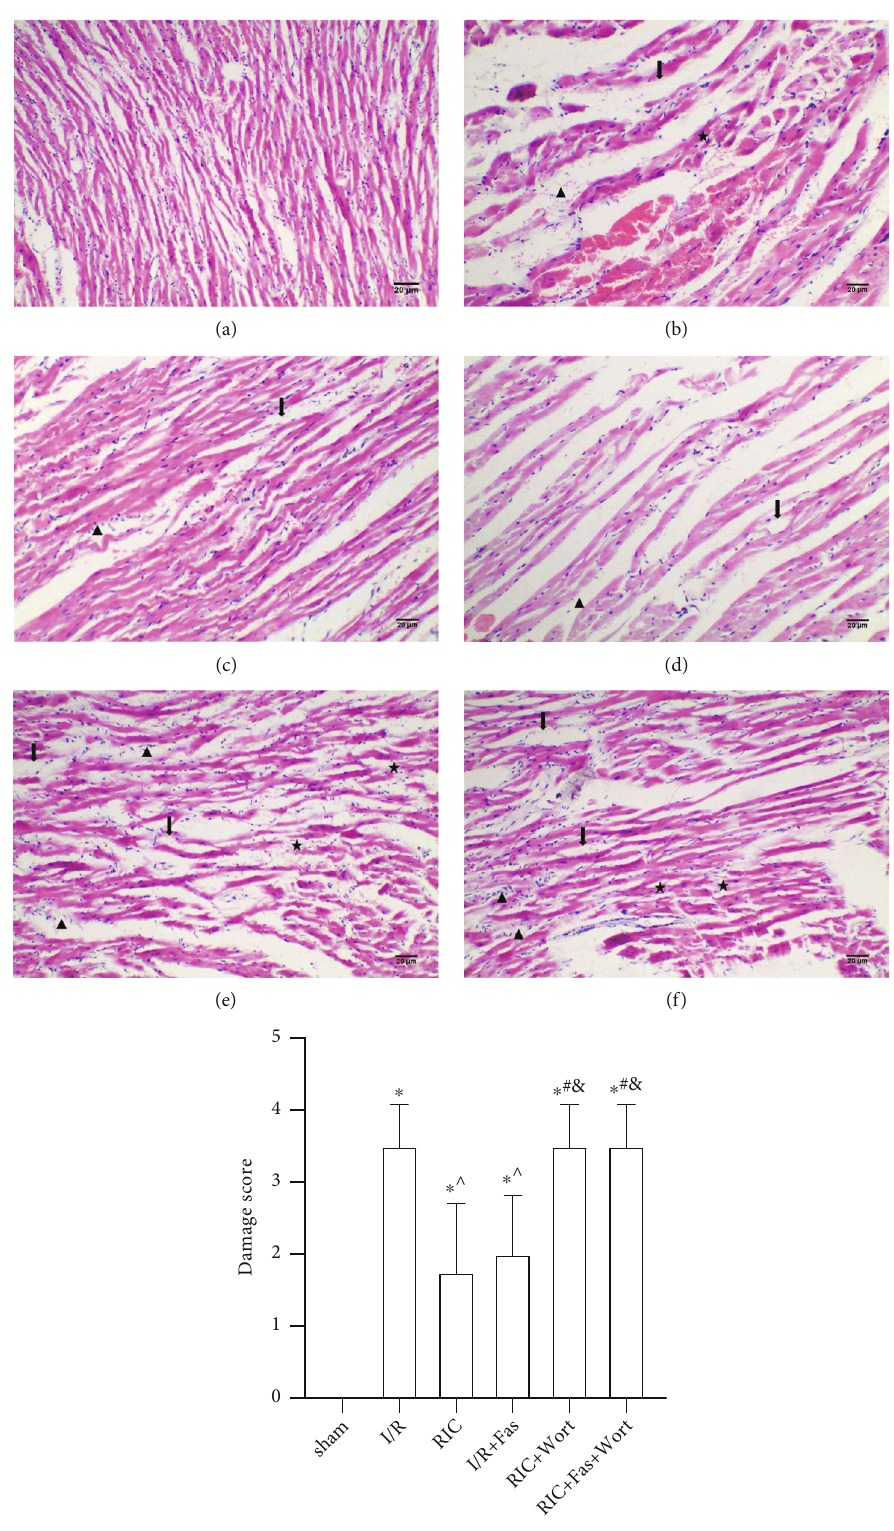
Figure 4: The histological changes in the myocardial tissue in the di ff erent groups ( × 100). Scale bar, 20 μ m. ( ★ ) myocardial fi ber disorganization; ( ↓ ) hemorrhage, stromal edema; ( ▲ ) in fl ammatory cell in fi ltration. (a) Sham group; (b) I/R group; (c) RIC group; (d) I/ R+Fas group; (e) RIC+Wort group; (f) RIC+Fas+Wort group; (g) damage score in di ff erent groups ( n = 4 ). ∗ P < 0 : 05 vs. sham group; ^ P < 0 : 05 vs. I/R group; # P < 0 : 05 vs. RIC group; & P < 0 : 05 vs. I/R+Fas